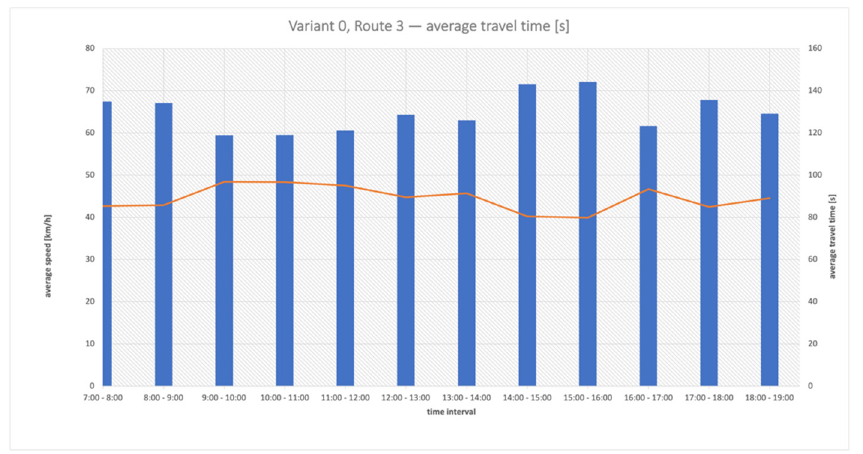
Figure 5. Variant 0; Section 2—average travel time [s].